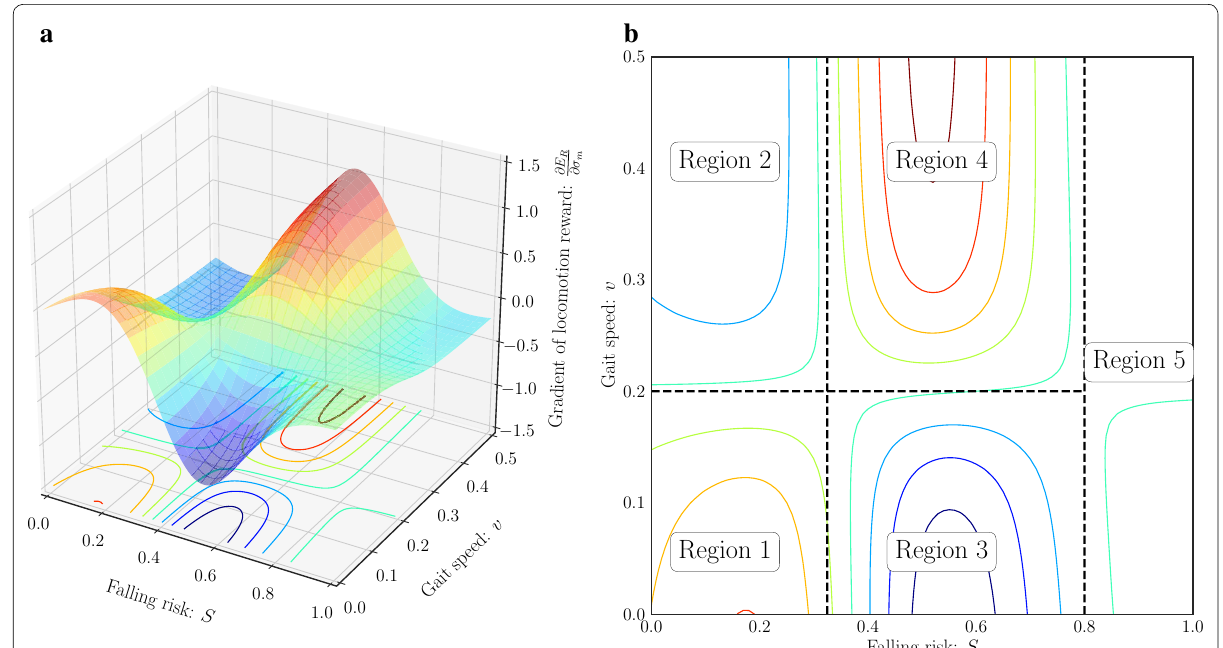
Fig. 6 A sample of the gradient this gradient is divided into five regions; when stable state, the robot expects to go to/stay in high speed; when uncertain state, the robot expects to go to/stay in low speed; when further unstable state, the robot judges that this region is out of scope of VM-SAL. a Overview, b region